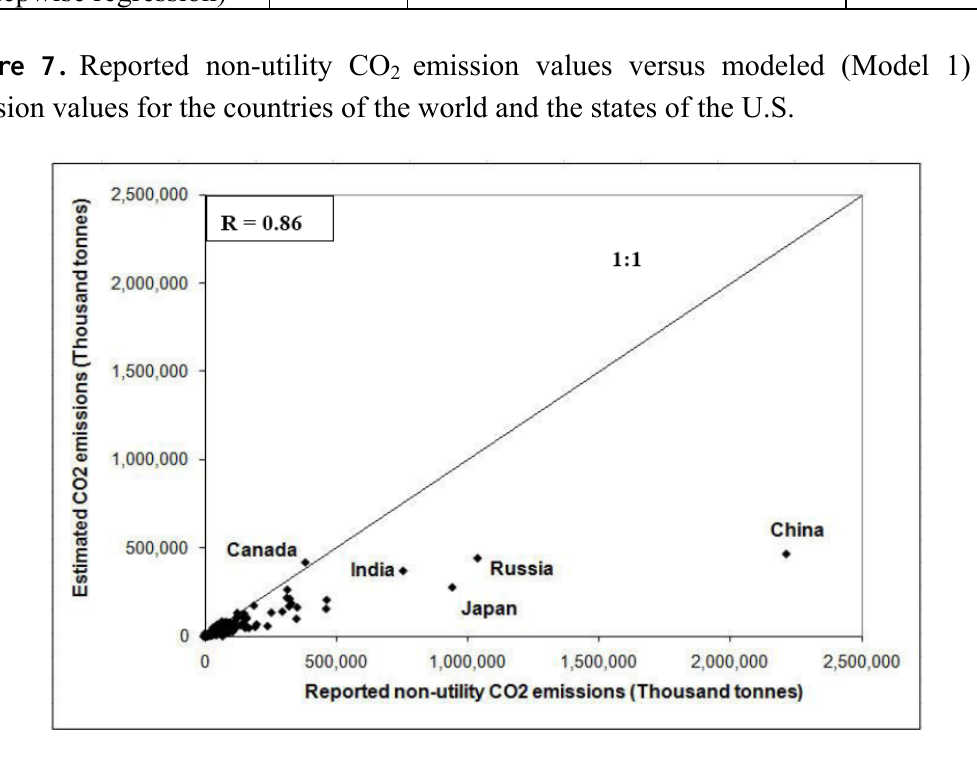
emission values versus modeled (Model 1) CO 2